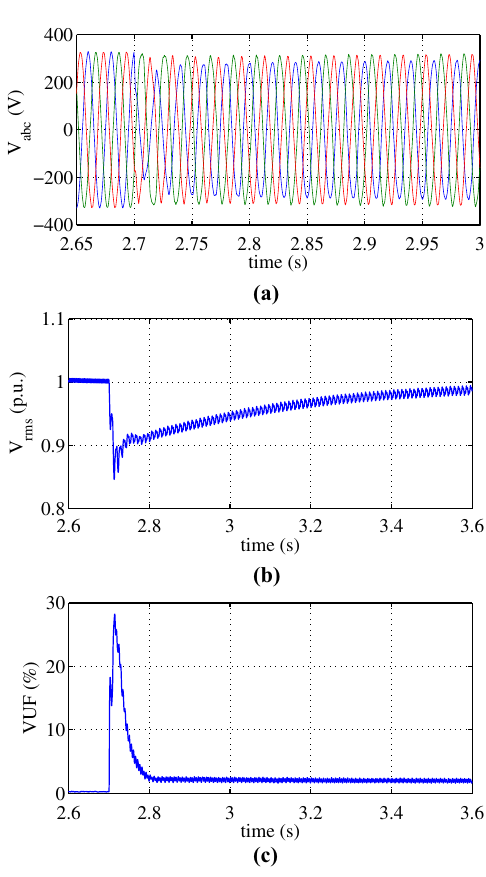
Figure 5. Bus voltage transient performance under single phase load. (a) Bus voltage, (b) RMS voltage, (c) voltage unbalance